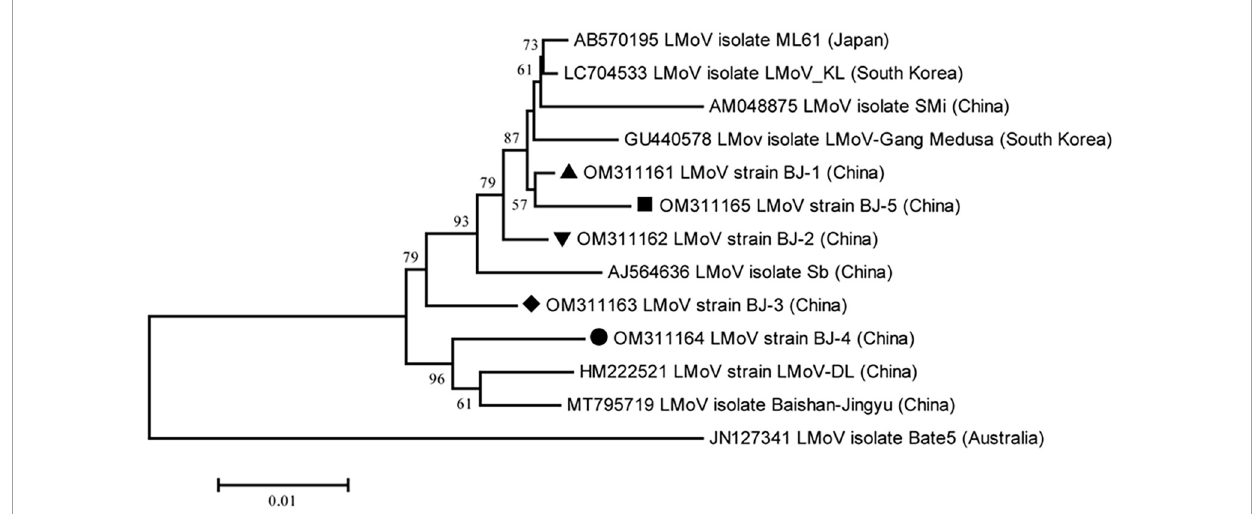
FIGURE5 Phylogenetic analysis of the lily mottle virus (LMoV) based on the polyprotein sequences of all available complete genome sequences constructed with NJ method with 1,000 bootstrap replicates. Bootstrap values are given by numbers at the relevant nodes in the topology and only bootstrap values of ≥ 50% were shown. LMoV BJ-1 (OM311161) was indicated with solid black triangle, LMoV BJ-2 (OM311162) was indicated with inverted solid black triangle, LMoV BJ-3 (OM311163) was indicated with solid black rhombus, LMoV isolate BJ-4 (OM311164) was indicated with solid black circle, and LMoV isolate BJ-5 (OM311165) was indicated with solid black